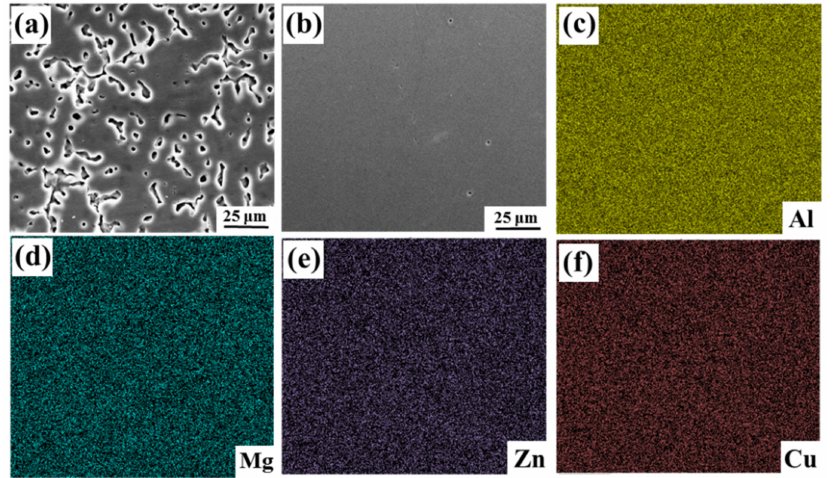
Figure 1. SEM micrographs and corresponding EDS results of the Al-10.0Mg-1.0Zn-0.15Cu (wt%) alloy: ( a ) as-cast, ( b ) as-homogenized, ( c – f ) the EDS results of ( b